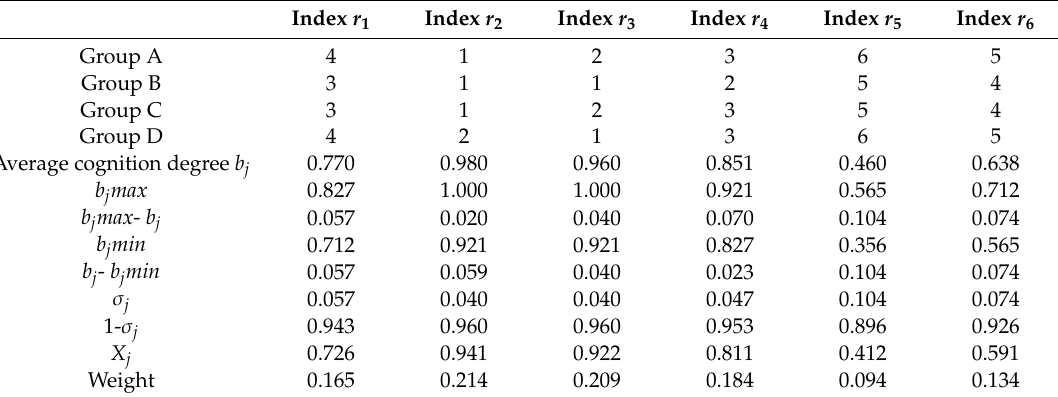
Table 3. Weight distribution of the first grade index.